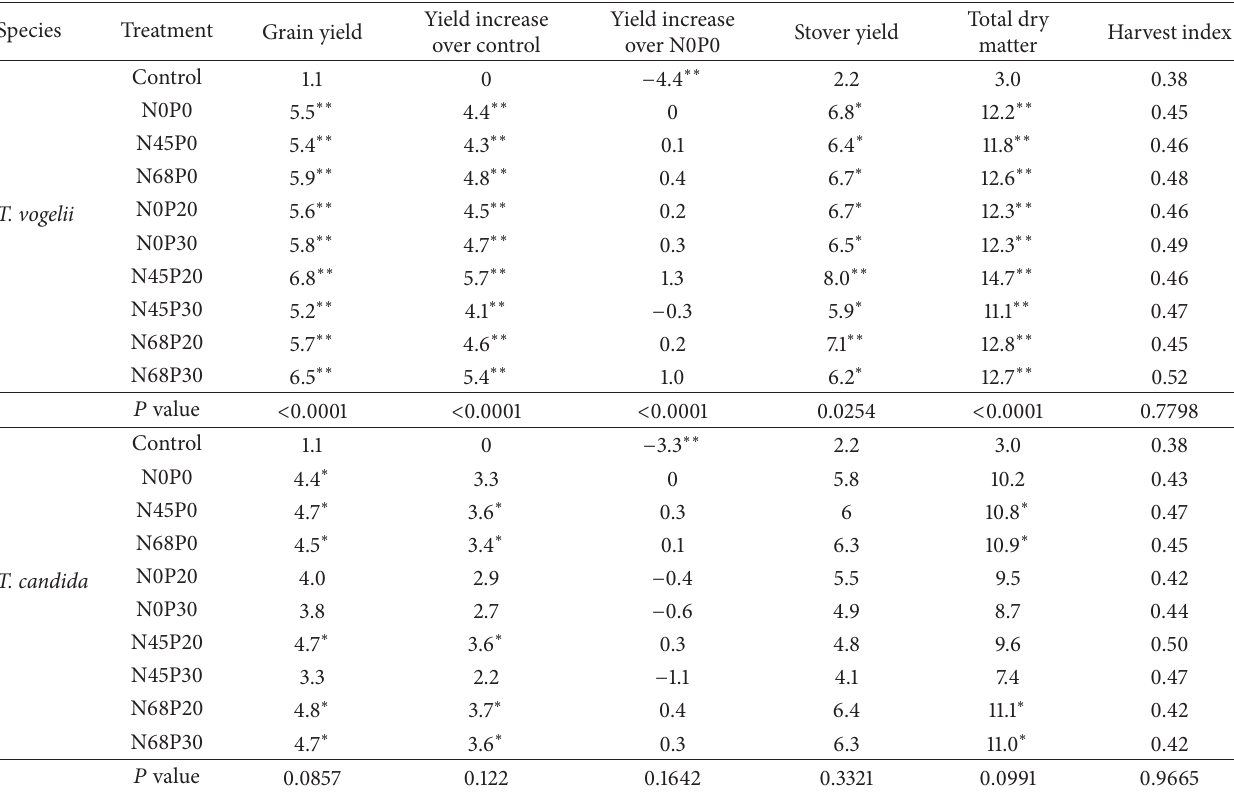
Table 6: Effect of T. vogelii and T. candida fallows and inorganic fertilizers on maize grain yield (t/ha), average yield increase (t/ha) over control and N0P0 (unfertilized fallow), stover and dry matter yield (t/ha), and harvest index (%) of species. Species Treatment Grain yield